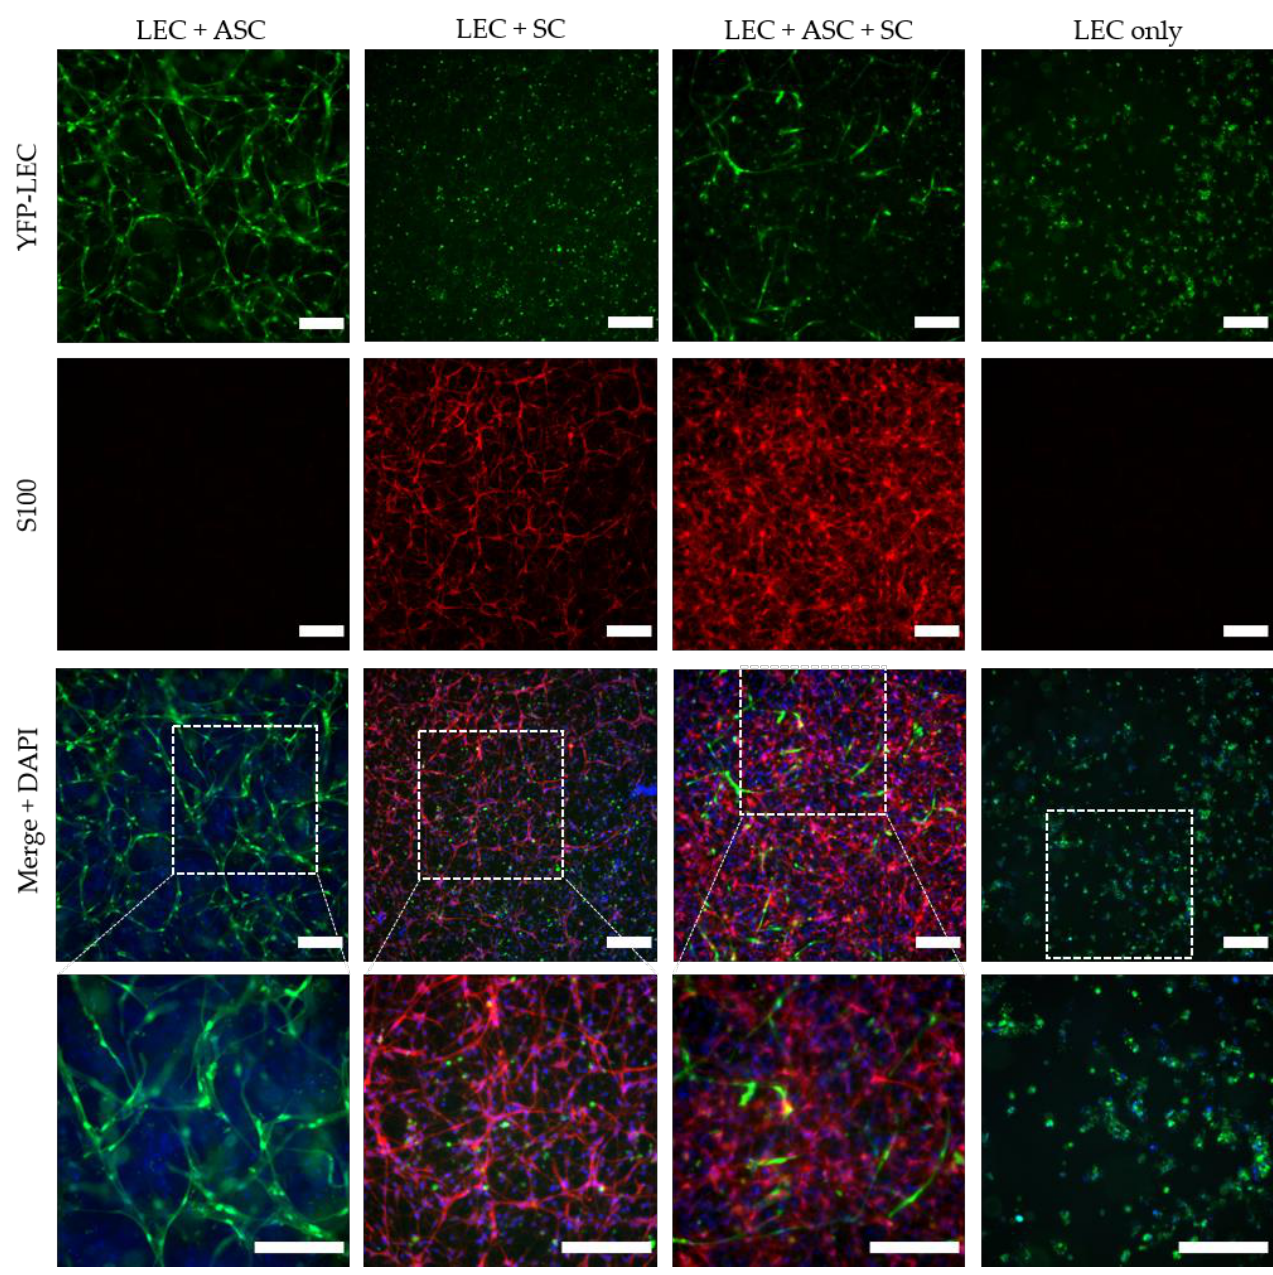
Figure 8. Schwann cells hinder lymphatic vascular network formation in the presence of the pro- inflammatory cytokine TNF- α . LEC + ASC formed elongated and interconnected networks, even when stimulated with TNF- α ; whereas the formation of lymphatic vessel-like structures in the LEC + ASC + SC cultures in the presence of TNF- α was hampered. The co-culture of only LECs and SCs did not show the formation of lymphatic tubes. Green—YFP-LECs, red—SCs stained against S100, blue—cell nuclei. Scale bars = 200 µ